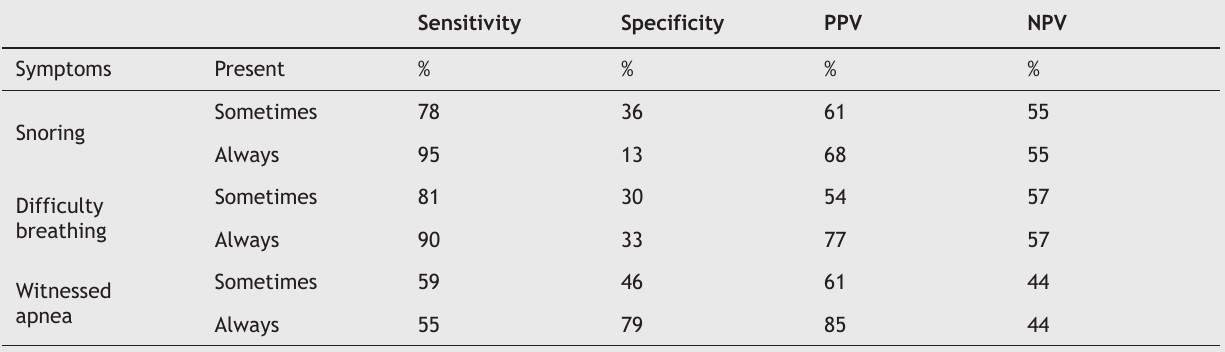
Table 6 Sensitivity, specificity, positive predictive value, and negative predictive value of symptoms in children 75 (B).